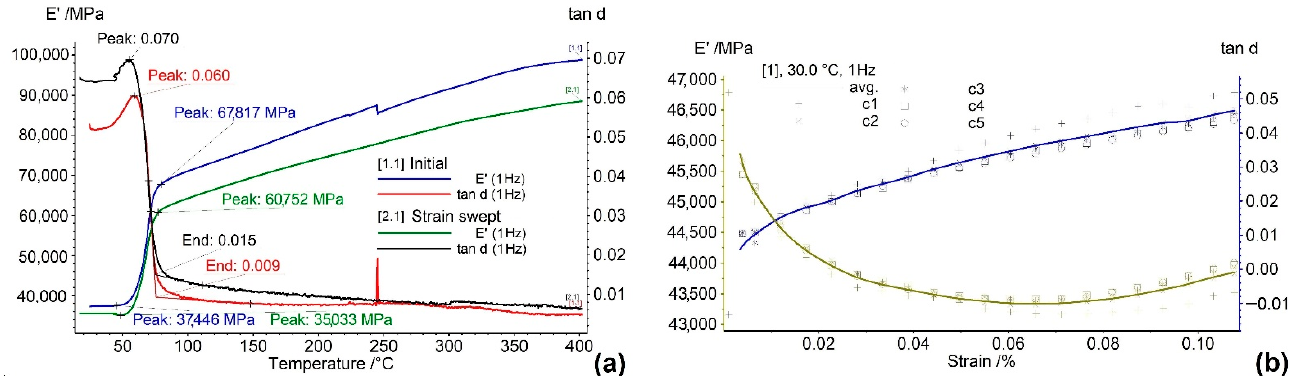
Figure 8. DMA thermograms illustrating the variations in the storage modulus ( E’ ) and internal friction ( tan δ ) of hot-rolled specimens as a function of ( a ) temperature during temperature scans in the initial state and after an isothermal strain sweep at RT; ( b ) strain amplitude during strain sweep at RT.